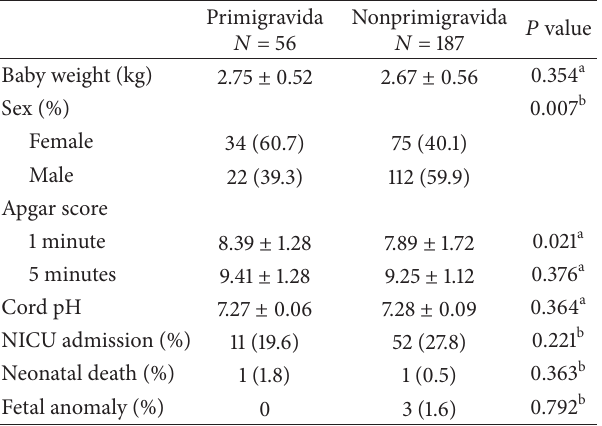
Table 5: Neonatal outcomes of women with major placenta